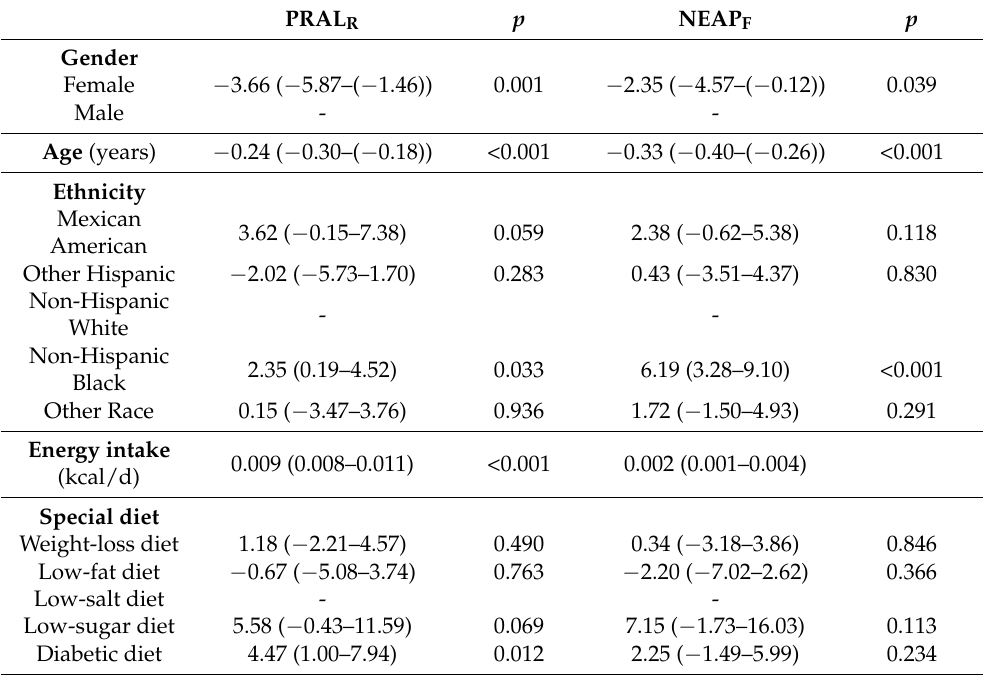
Table 3 legend: Coefficients are displayed with their 95% confidence intervals and p -values. The symbol “-” indicates the reference category. p = p -value. Marginsplots were used to graph statistics from the fitted models shown above.